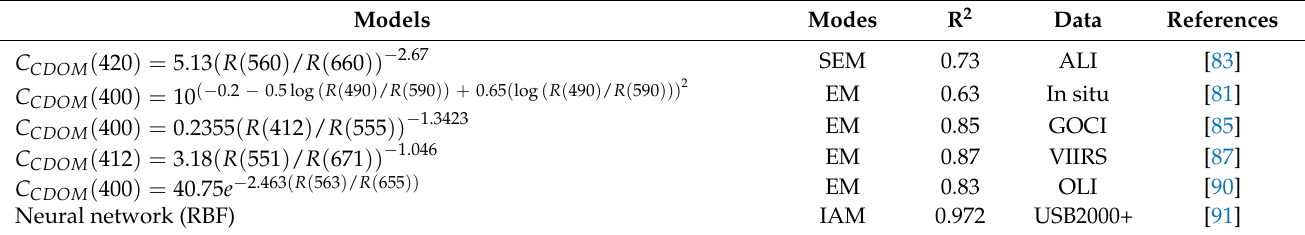
Table 4. Inversion models of CDOM Concentration.